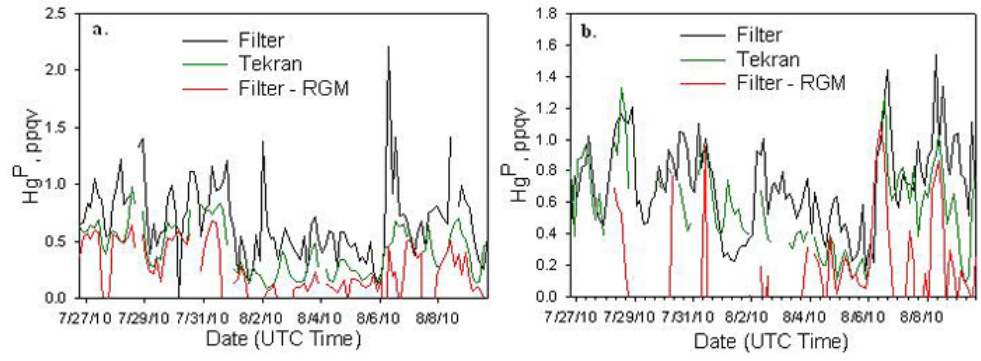
Fig. 11. Comparison of Tekran data (green) and bulk filter data (black) with filter-RGM data (red) from Thompson Farm (a) and Appledore Island (b) . It appears that Thompson Farm may occasionally be affected by a RGM artifact as shown by the red data, while Appledore Island filters track the Tekran much better which may be a result of removal of the impactor on the Tekran at Appledore Island. It is still unclear if RGM affects Hg P measurements using filters.